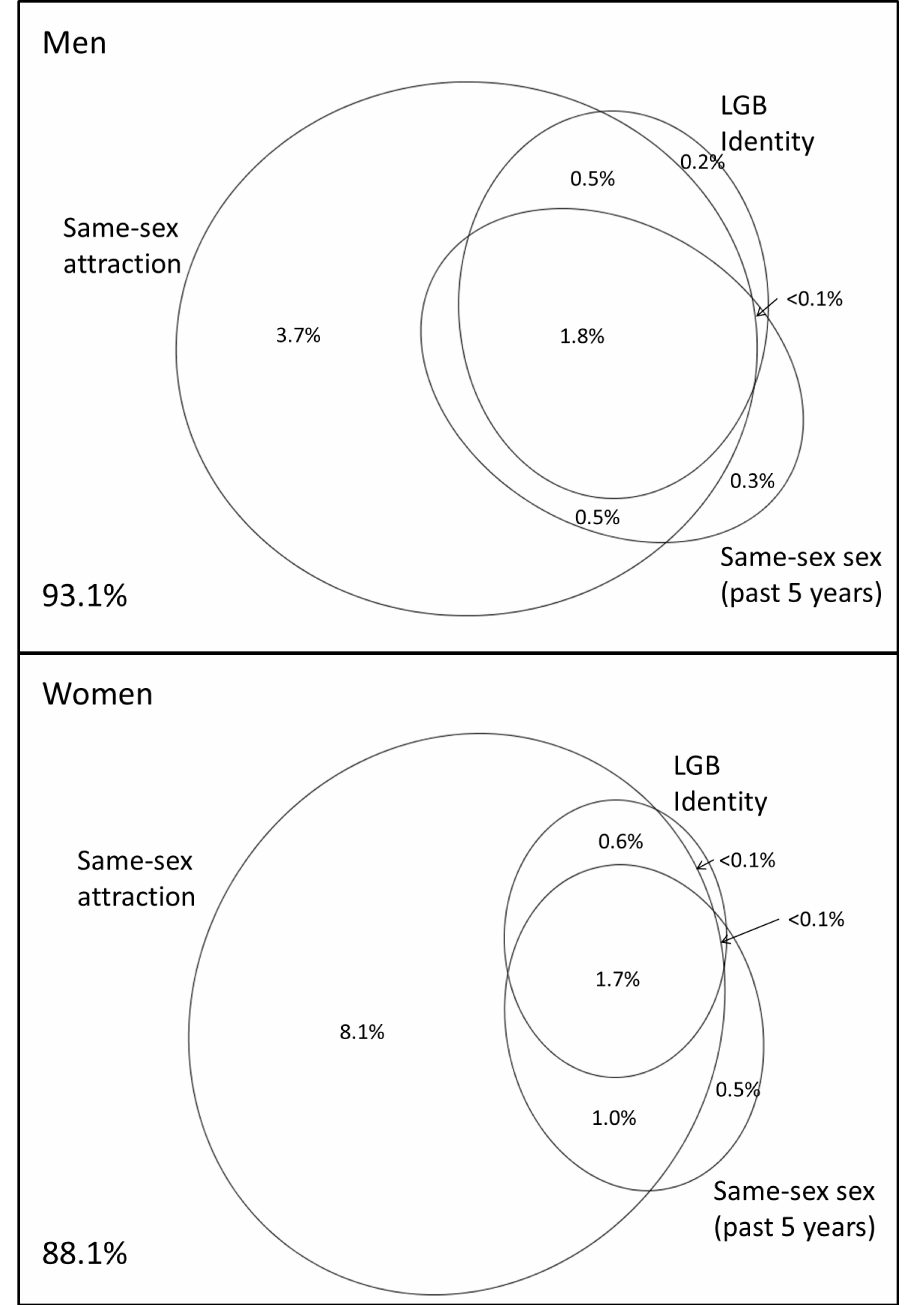
Fig 2. The overlap between same-sex sexual attraction (ever), LGB sexual identity and same-sex sex within the past 5 years for men and women. as LGB and reported same-sex attraction and had had same-sex sex in the past 5 years. How- ever, a higher percentage of women than men reported same-sex sex and/or same-sex attrac- tion without reporting an LGB identity.